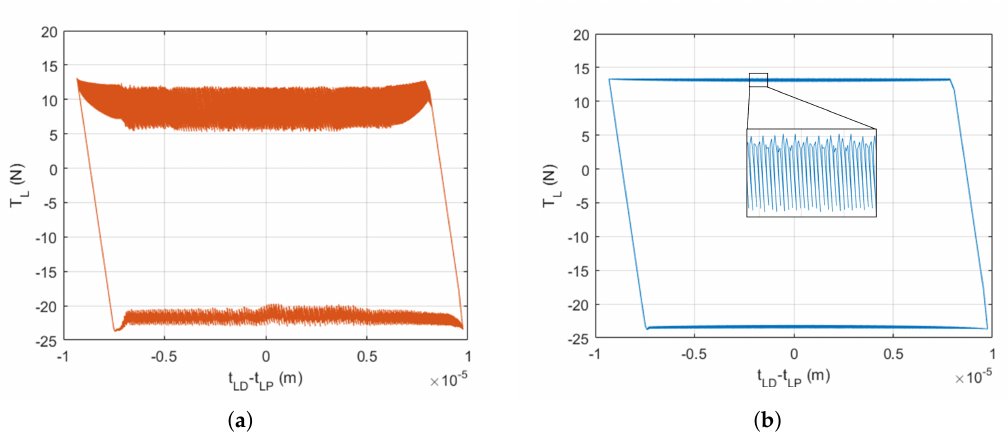
Figure 6. ( a ) Low frequency hysteresis cycle at the left contact obtained through DTI without additional post-processing. ( b ) Low frequency hysteresis cycle at the left contact obtained through DTI and an a posteriori low-pass